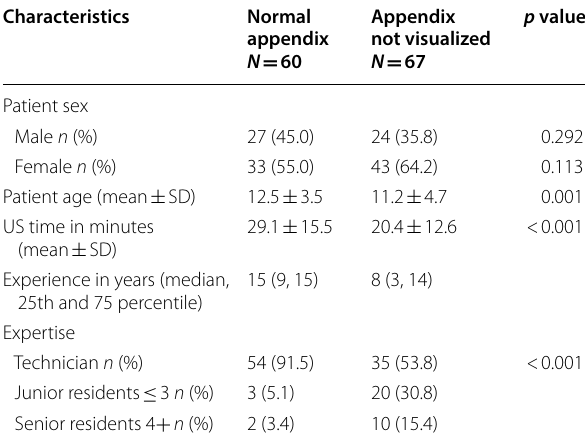
Table 1 Description of sample and univariate